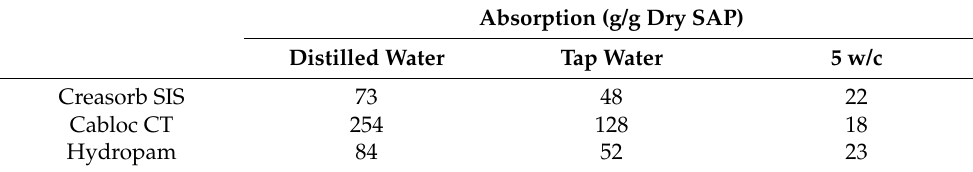
Table 1. Absorption of selected SAPs.